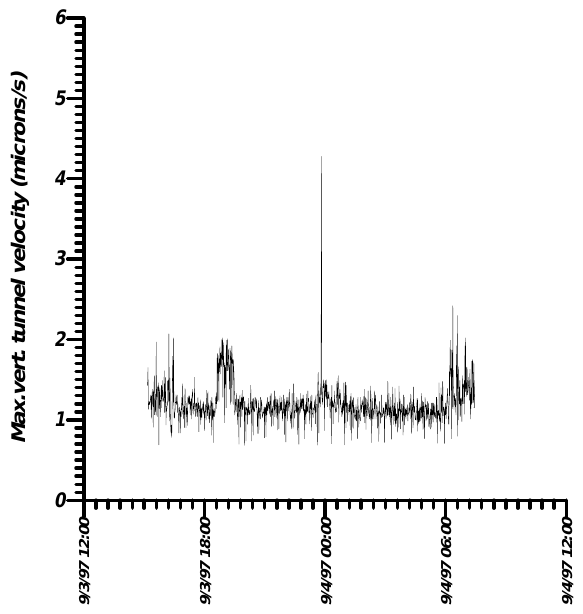
FIG. 6. Vibration amplitudes in the tunnel of the Tevatron over 16 h starting 3:30 p.m. September 3, 1997. The main ring and the Tevatron ring are operating.